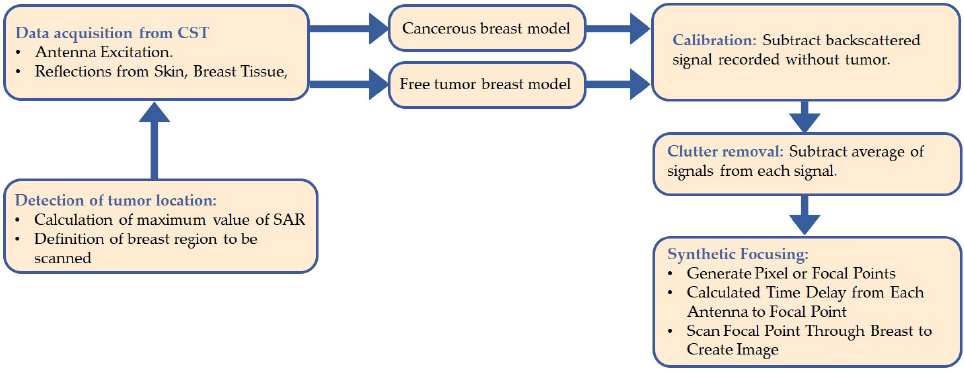
Figure 5. Process flow diagram of the novel